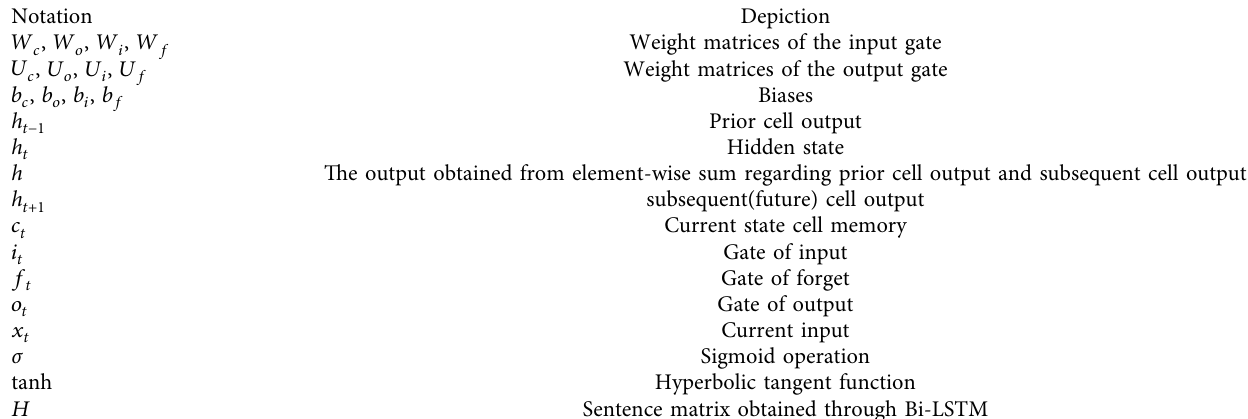
Table 2: Notations used during forward and backward LSTM.